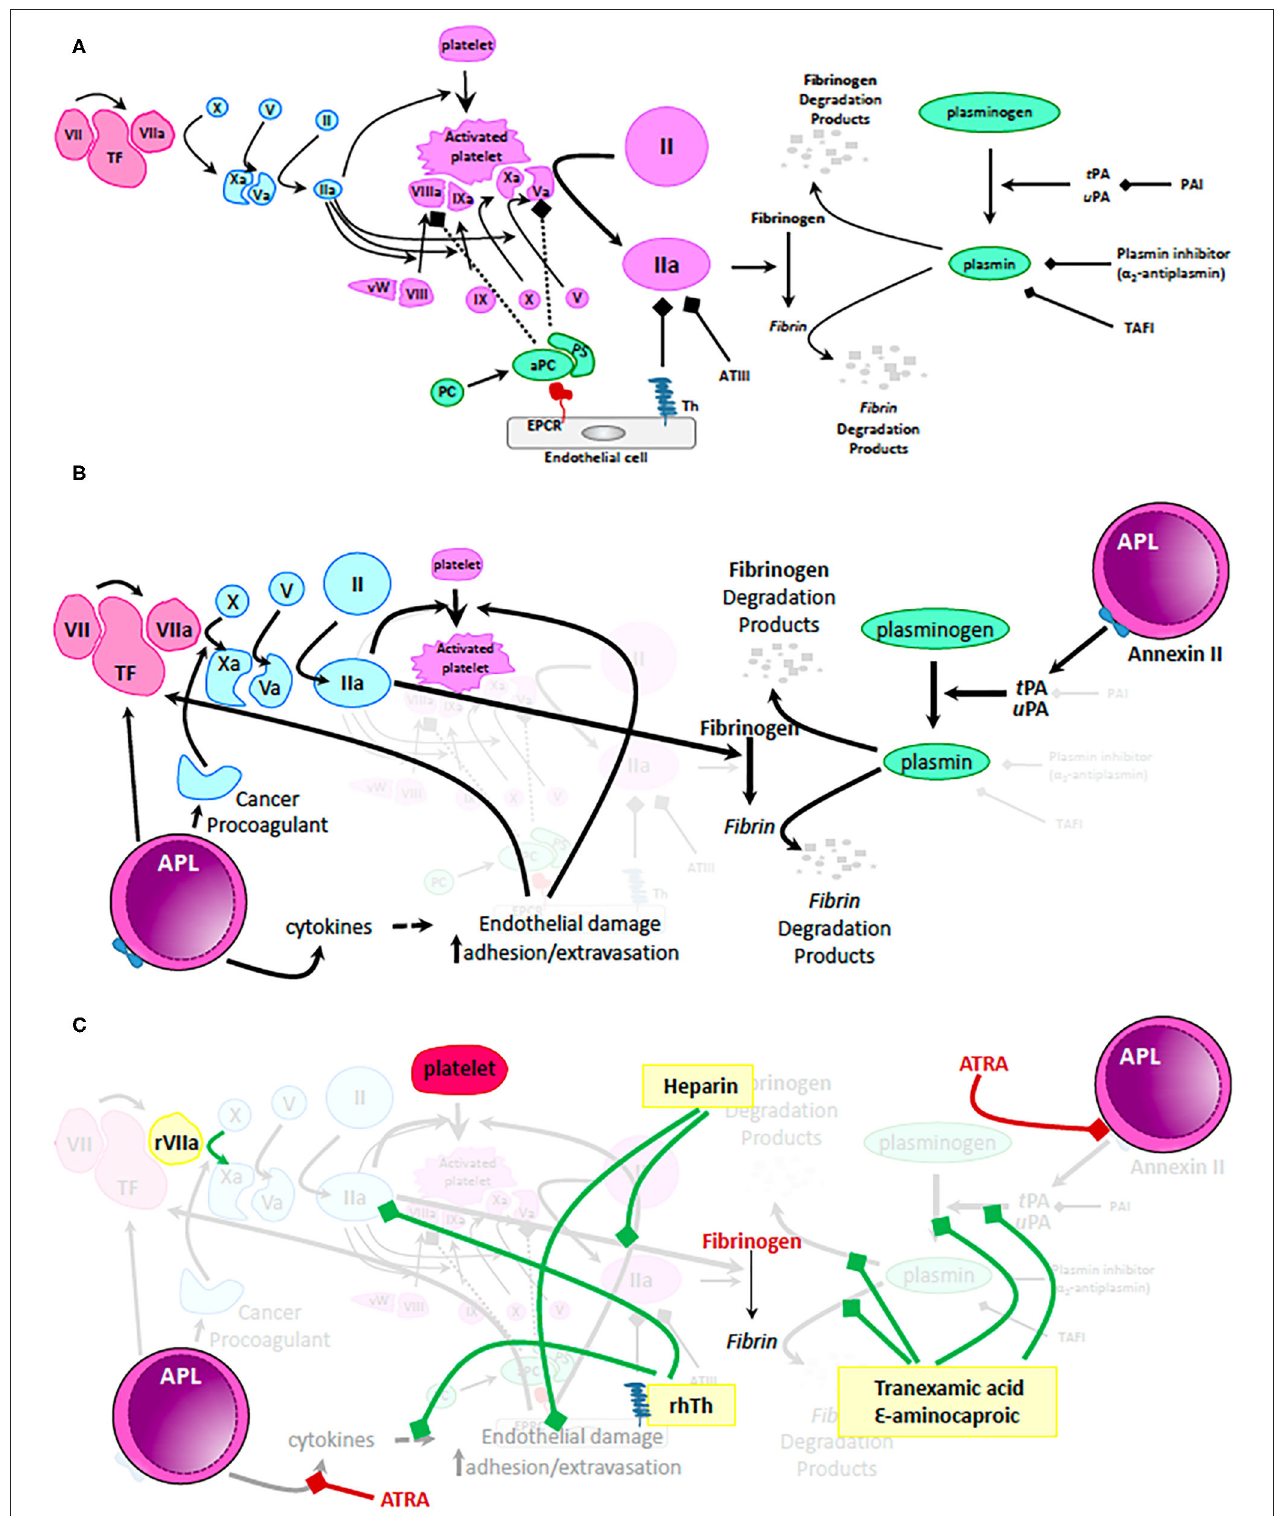
FIGURE 1 | Mechanisms of coagulopathy in APL. (A) Physiologic mechanisms of coagulation and anticoagulation. Tissue factor (TF) released by trauma to the vascular wall activates factor VII. Small amounts of activated factor VII (VIIa) activates factor X which in turn activates factor V. Activated factor X (Xa) together